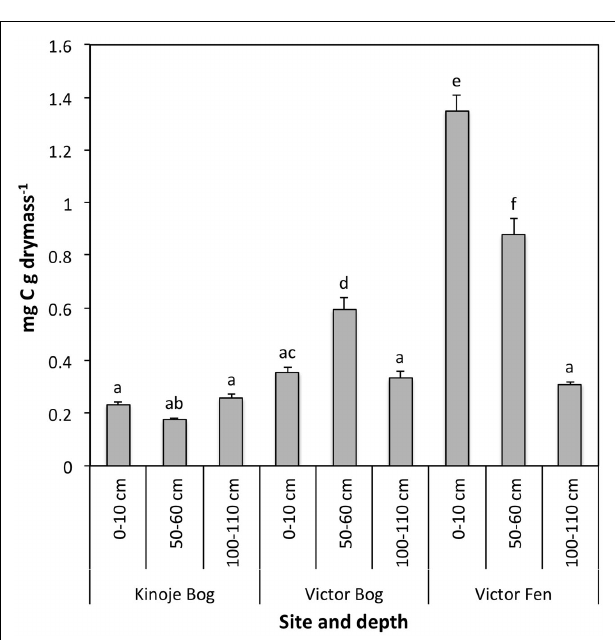
FIGURE 2 | Basal respiration (mean ± 1SE; n = 3) in an oxic environment after 24h in peat collected at three depths across three James Bay peatlands. Different letters indicate significance difference at p <